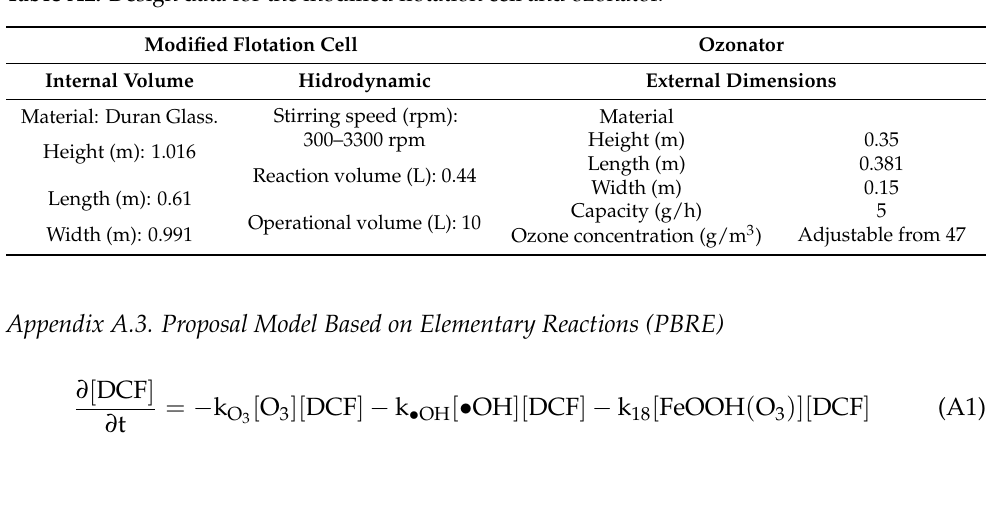
Table A2. Design data for the modified flotation cell and ozonator.